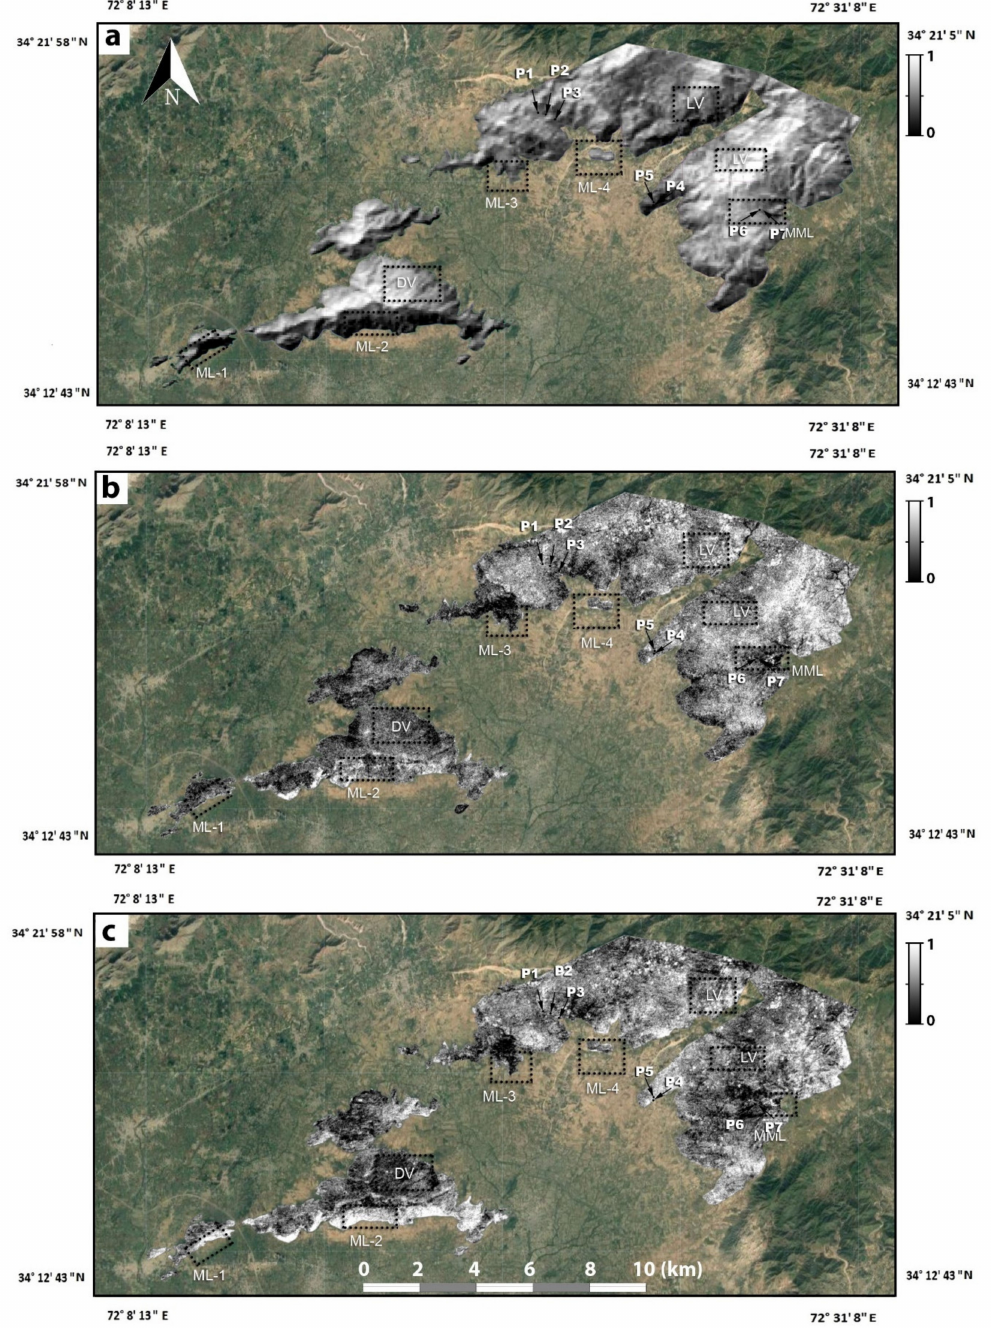
Figure 8. ( a ) PC1 of the raw ASTER data (the negative loadings of all bands generally represented albedo and topographic effects); ( b ) PC6 of the raw ASTER data showing granite in darker and medium-toned pixels with very little information about marble due to the lower resolution of the ASTER images; ( c ) PC5 of the stretched ASTER data showing granite in brighter to medium-toned pixels and marble in darker